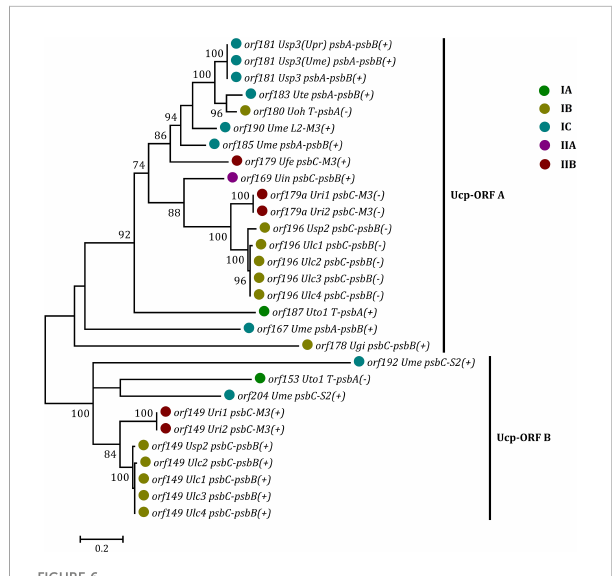
FIGURE 6 Phylogenetic analysis of the 29 full-length free-standing Ucp-ORFs found in Ulva plastomes. The bootstrap support values greater than 70% were displayed at branches. Branch lengths were proportional to the amount of sequence change, which were indicated by the scale bar below the trees. Different colored circles represent different Ulva